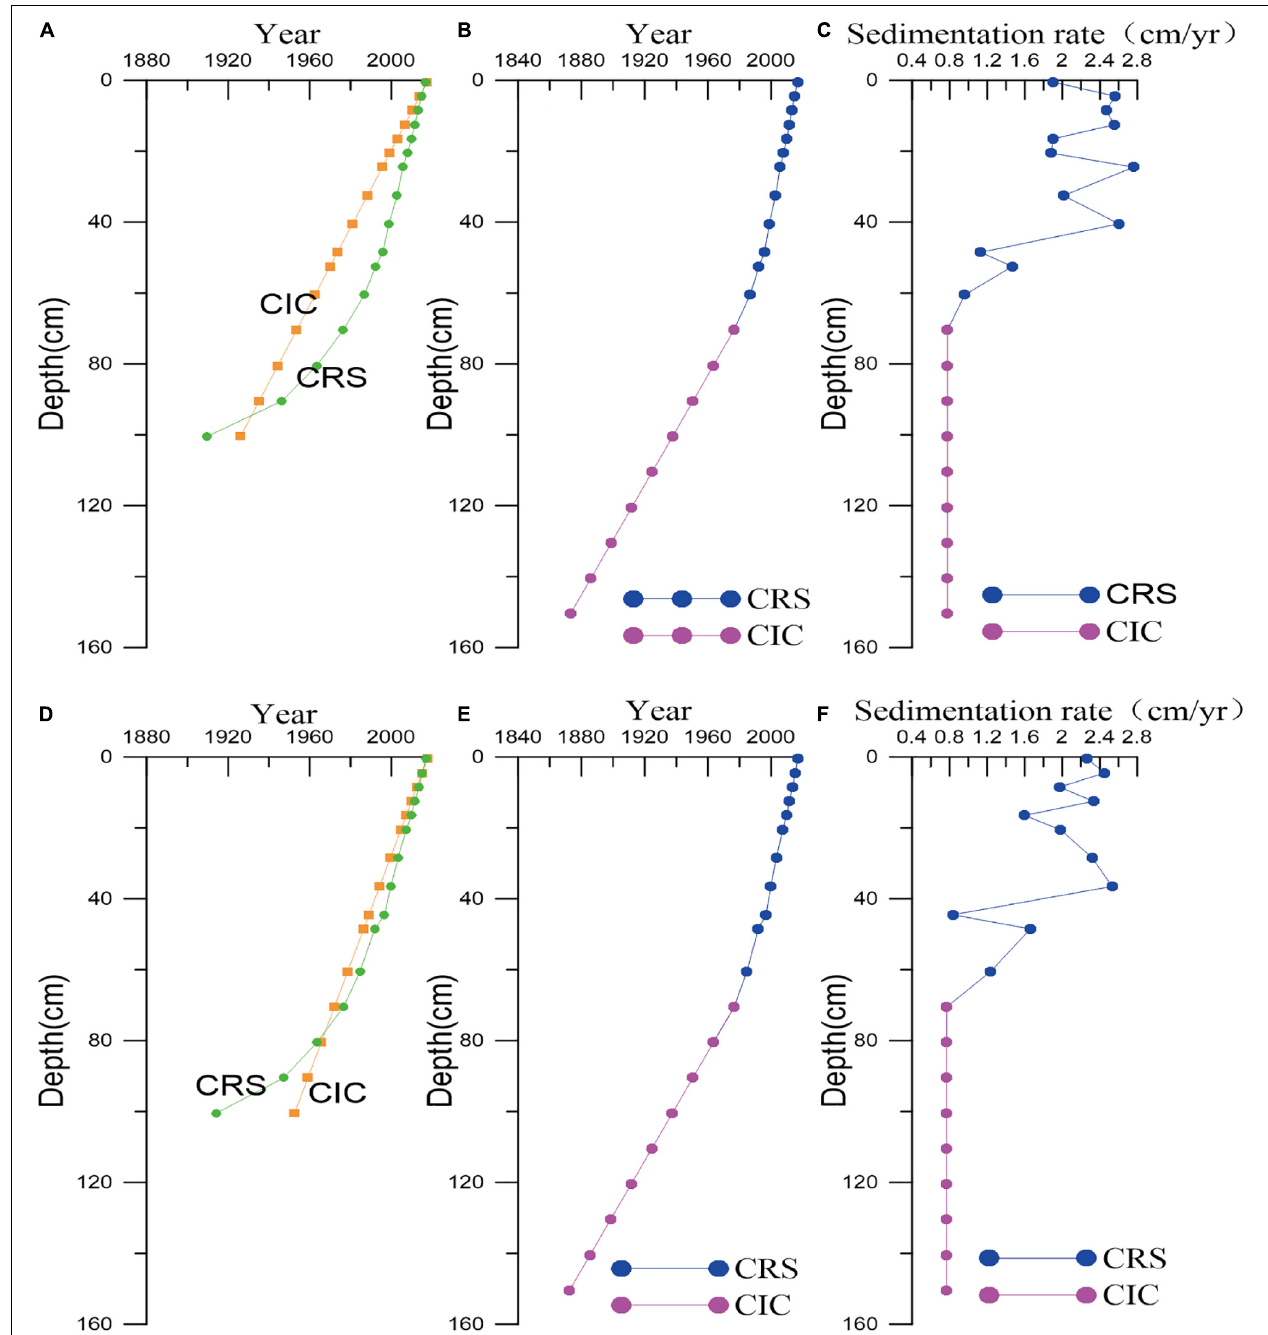
FIGURE 3 | Dating result and sedimentation rate for core Z7 (A–C) and Z8 (D–F) . The CRS and CIC dating models were combined to establish a dating framework for core Z7 (B) and Z8 (E) , with the CRS model being used for depths of 0–70 cm and the CIC model for depths of 70–150 cm, to get a more accurate dating framework. (A , D) Show the difference between CIC and CRS single dating model results for depths of 0–100 cm. The sedimentation rate for core Z7 (C) and Z8 (F)